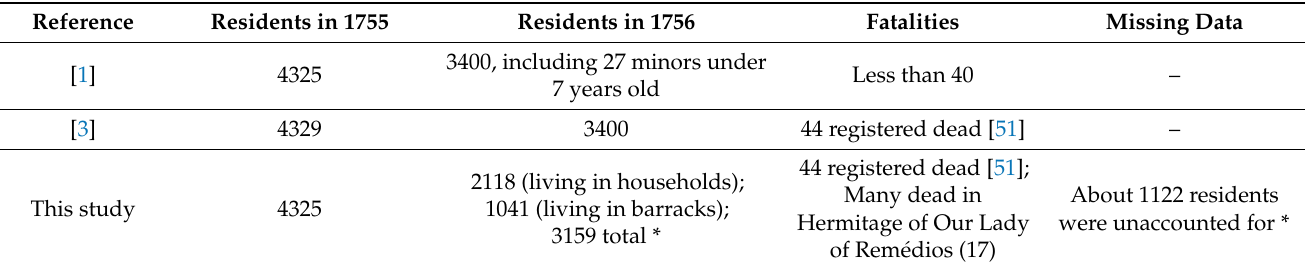
Table 2. Number of residents (before and after the earthquake) and the number of fatalities at Santo Estev ã o civil parish. The population data consider people older than seven years of age. Location of Hermitage indicated on Figure 4. Several discrepancies have been found